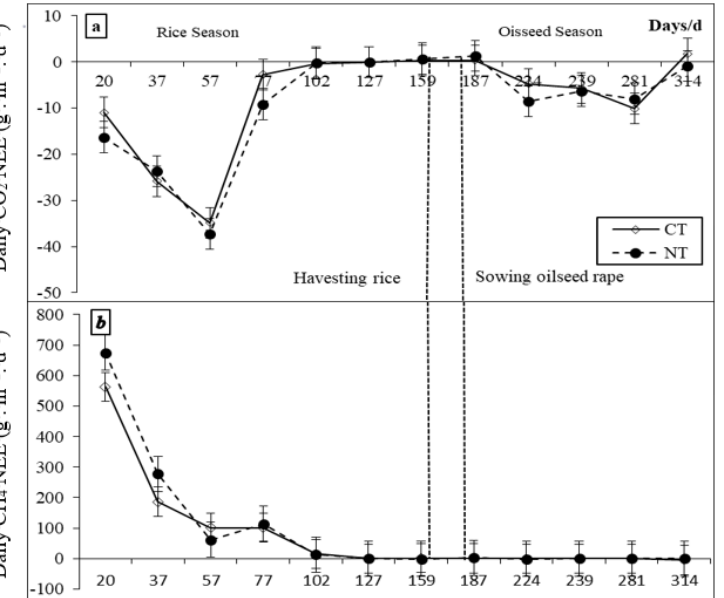
Figure 2. Changes in daily CO 2 ( a ) and CH 4 ( b ) net ecosystem exchange (NEE) under conventional